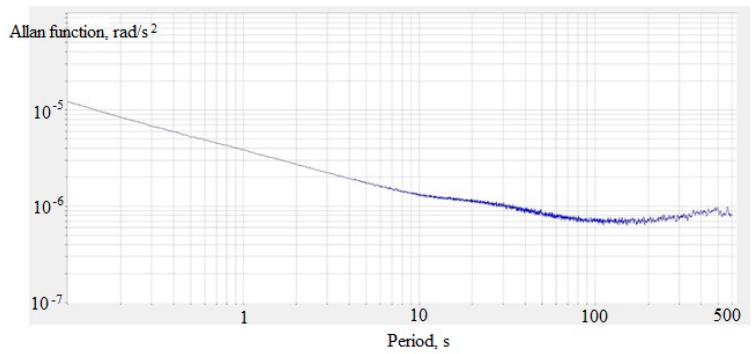
Figure 11. Allan variance for molecular–electronic angular accelerometer with negative MHD feedback.